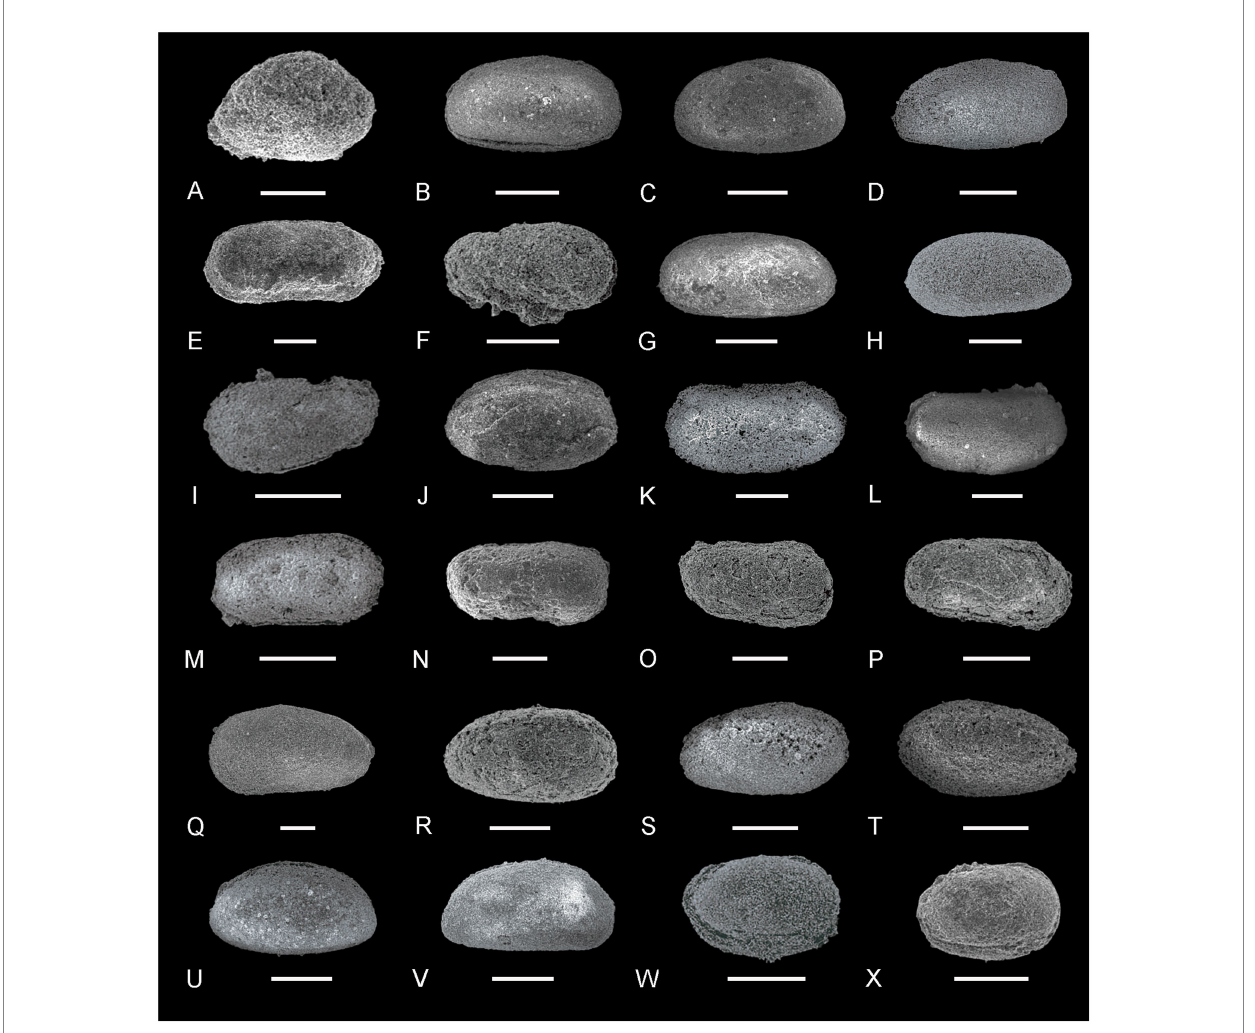
FIGURE 4 Ostracods from the Youping Section (II). (A) Cryptobairdia sp., right lateral view, sample YP-5; (B,C) Cytherella sp., right lateral view, sample YP-18; (D,E) Fabalicypris parva Wang, D : right lateral view, sample YP-18; E : left lateral view, sample YP-20; (F) Fabalicypris venusta Guan, right lateral view, sample YP-7; (G,H) Healdianella cf. subcuneola Posner, left lateral view, sample YP-18; (I) Hollinella sp., left lateral view, sample YP-7; (J) Hungarella tulongnsis Crasquin, right lateral view, sample YP-18; (K,L) Indivisia sp., right lateral view, sample YP-13; (M,N) Langdaia laolongdongensis Crasquin-Soleau and Kershaw, right lateral view, sample YP-7; (O,P) Langdaia cf. suboblonga Wang, right lateral view, sample YP-7; (Q,R) Liuzhinia antalyaensis Crasquin- Soleau, Q : left lateral view, sample YP-16; R : right lateral view, sample YP-7; (S,T) Liuzhinia guangxiensis Crasquin-Soleau, S : right lateral view, sample YP-19; T : left lateral view, sample YP-18; (U) Macrocypris cf. deducta Zalanyi, left lateral view, sample YP-19; (V) Macrocypris panxianensis Wang, right lateral view, sample YP-18; (W,X) Microcheilinella alborzella Forel, right lateral view, sample YP-19. Scale bars = 200 μ